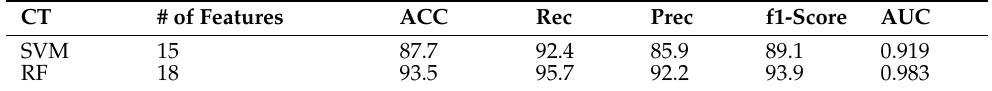
Table 5. Performance scores of SVM and RF for handwritten text